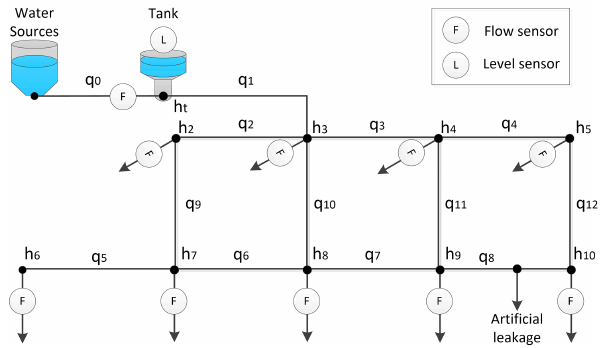
Figure 2. Illustrative diagram of the water transport network of this case study.